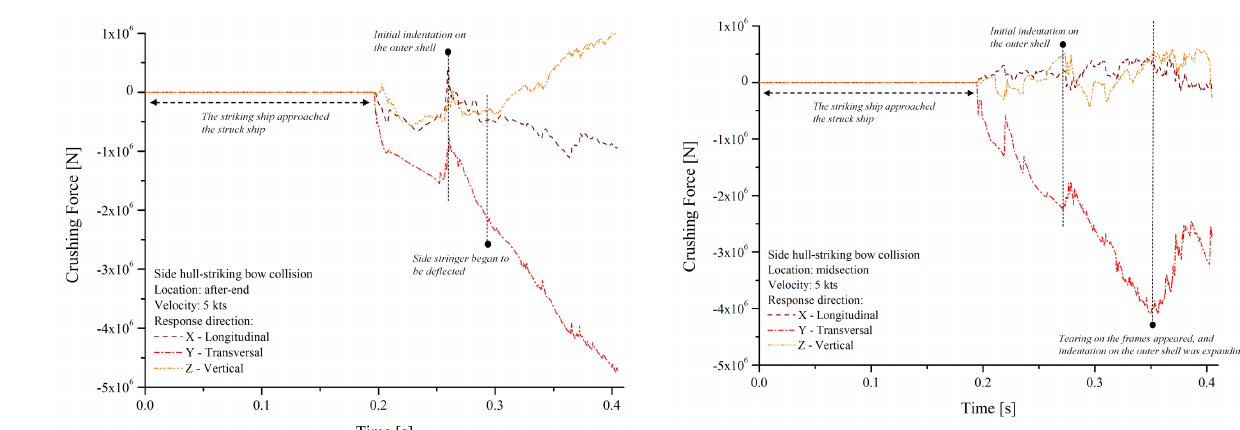
Figure 5: Patterns of crushing force, and sequences of progressive failure: after-end impacted by velocity 5 kts.